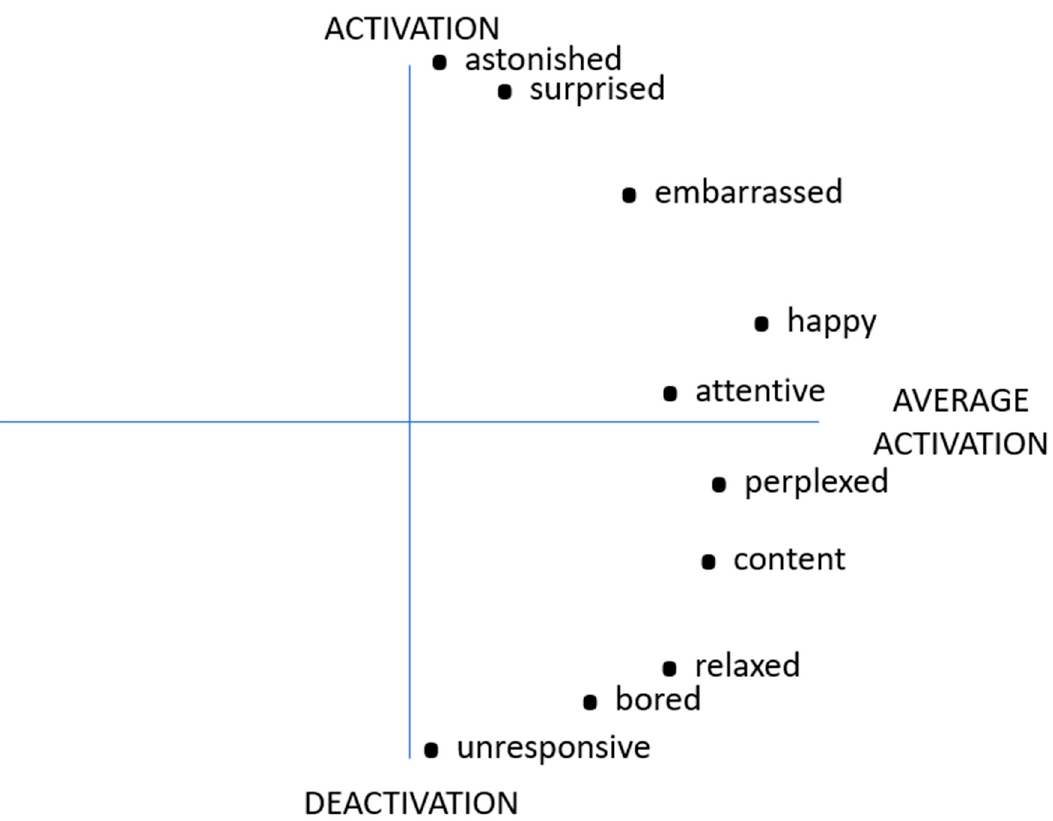
Figure 4. Considered emotions inspired by Russell's model.